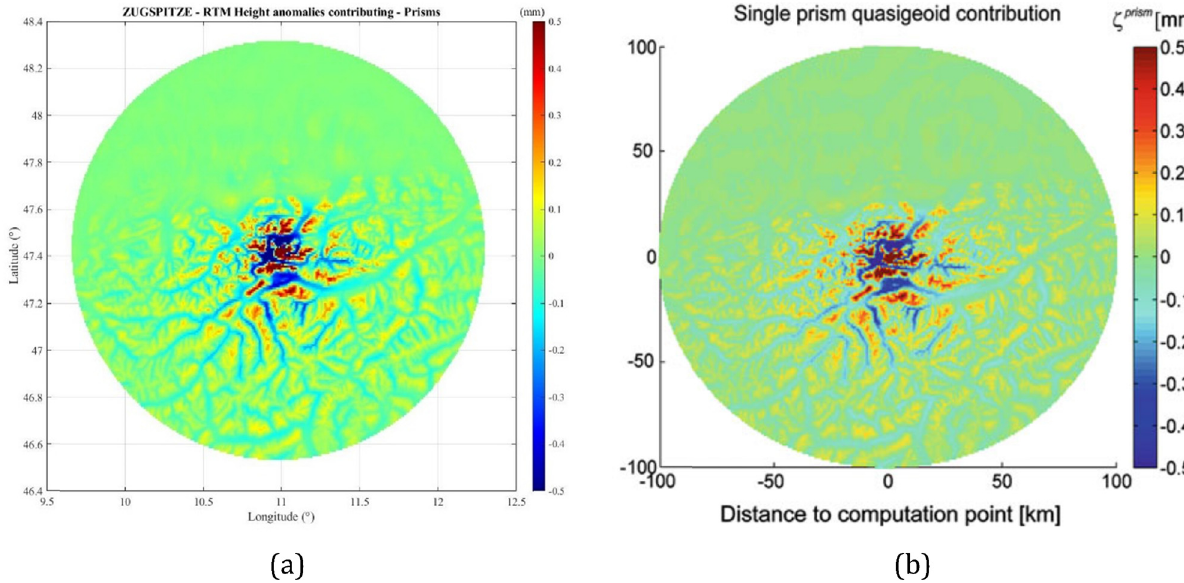
Figure 3: ( a ) RTM height anomaly contribution obtained by prism approach for the Zugspitze and ( b ) RTM height anomaly contribution obtained by Hirt et al. ( 2010 ) for the same